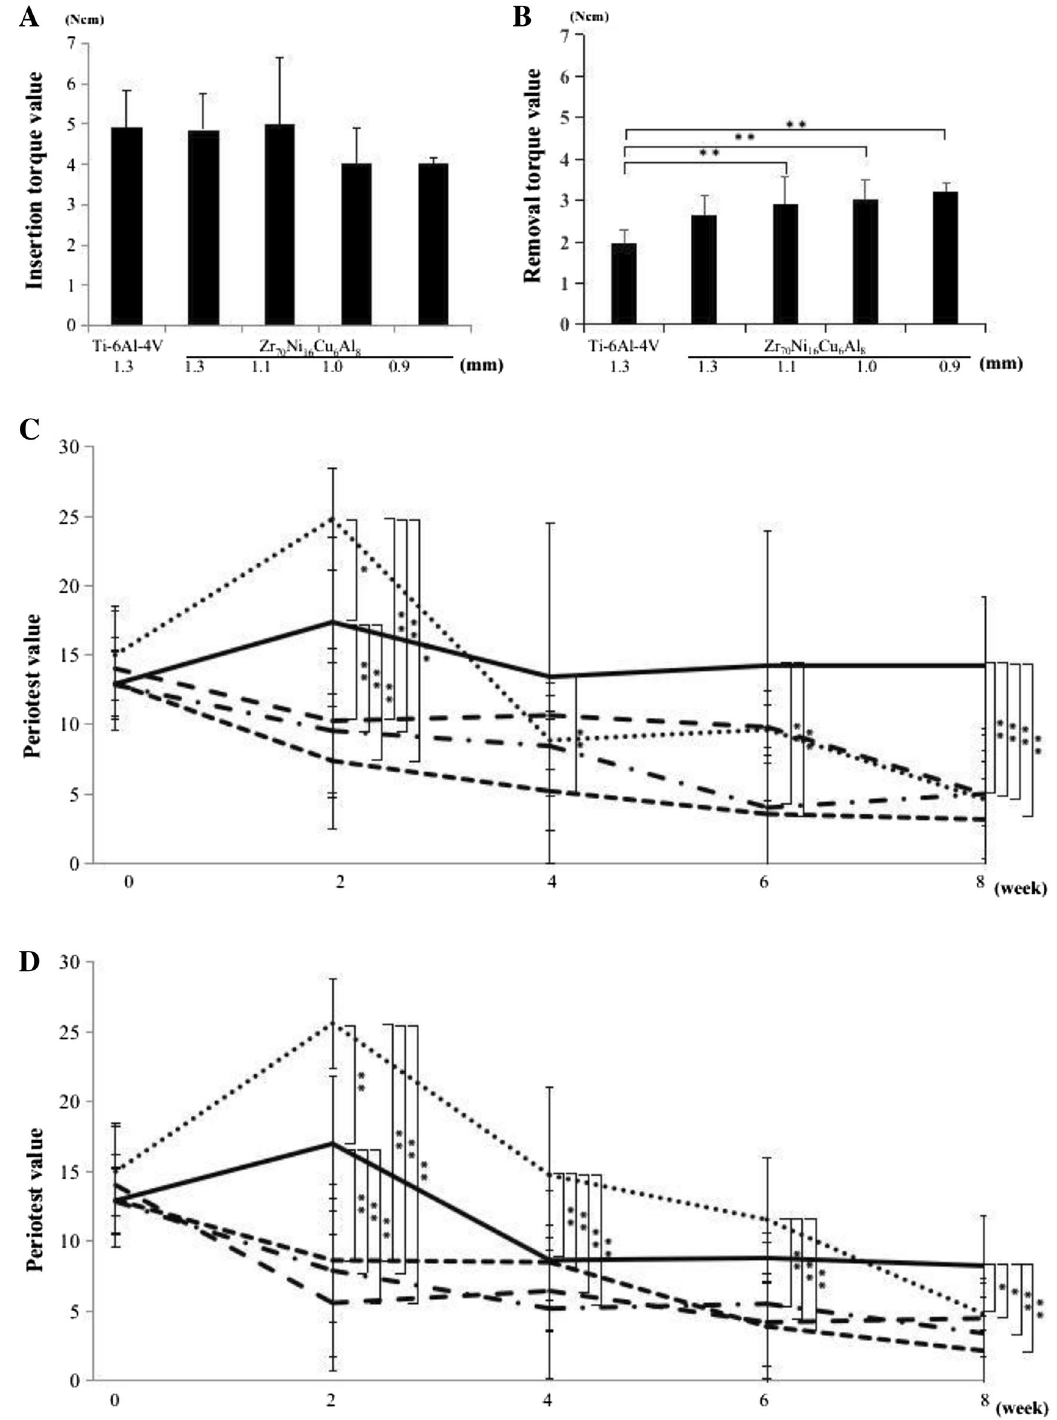
Figure 3. Insertion torque, removal torque and Periotest. ( A ) The insertion torque values of 0.9 mm (n = 20), 1.0 mm (n = 19), 1.1 mm (n = 19), and 1.3 mm (n = 16) diameter Zr 70 Ni 16 Cu 6 Al 8 BMG miniscrews and 1.3 mm diameter Ti-6Al-4 V miniscrew. ( B ) The removal torque values of 0.9 mm, 1.0 mm, 1.1 mm and 1.3 mm diameter